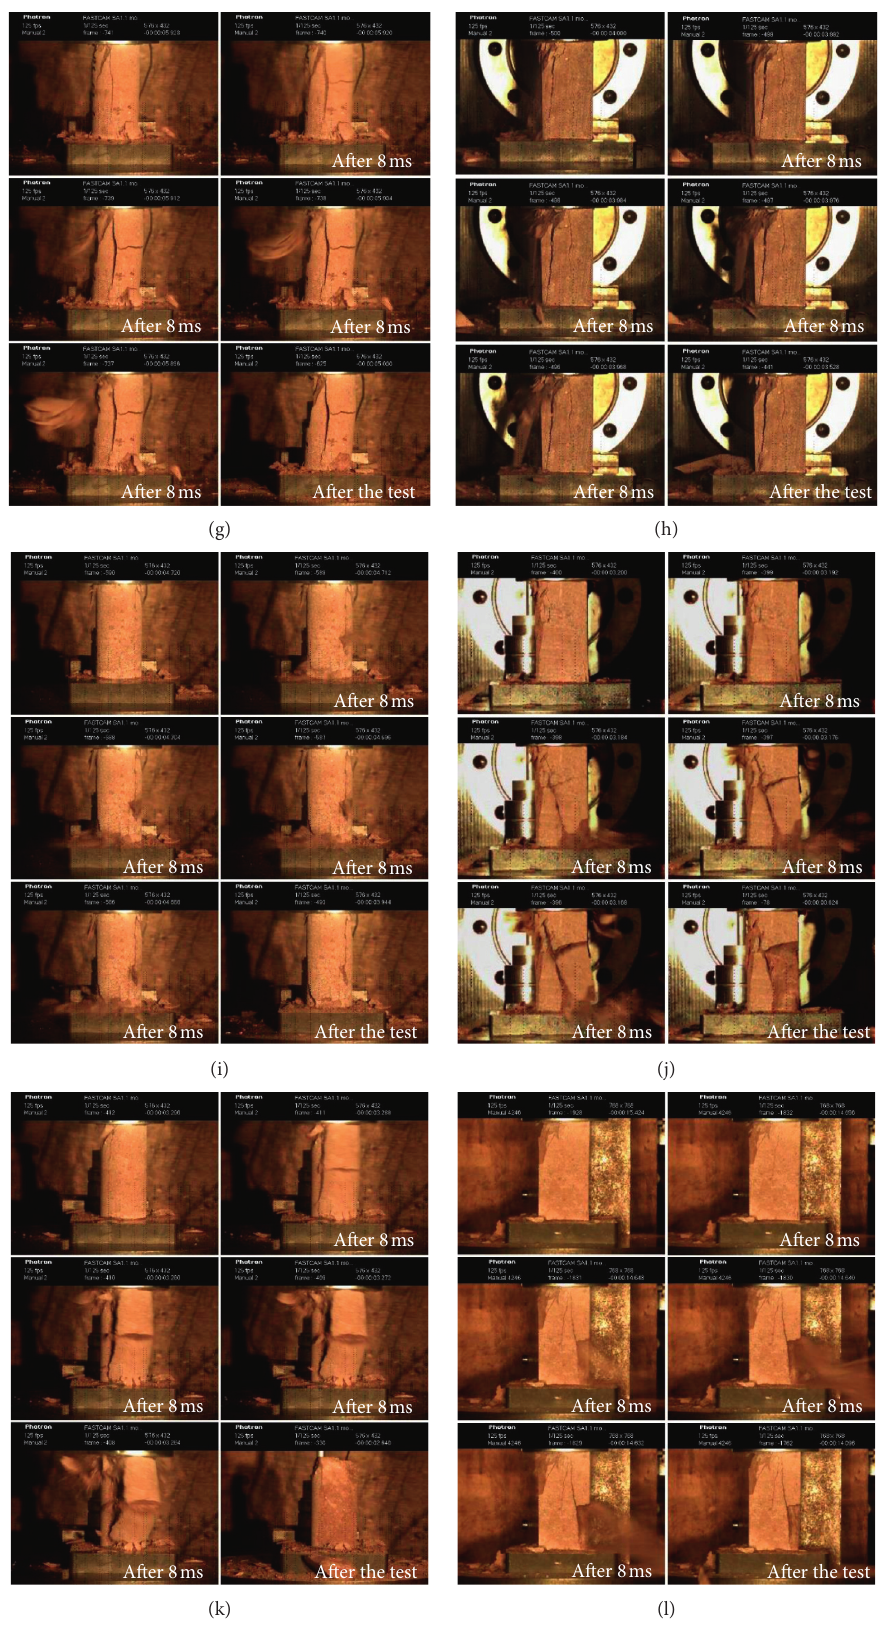
Figure 6: Failure process of specimens with uniaxial compression tests. (a) RS-CL-1. (b) RS-CB-1. (c) RS-CL-2. (d) RS-CB-2. (e) RS-CL-3. (f) RS-CB-3. (g) RS-CL-4. (h) RS-CB-4. (i) RS-CL-5. (j) RS-CB-5. (k) RS-CL-6. (l)